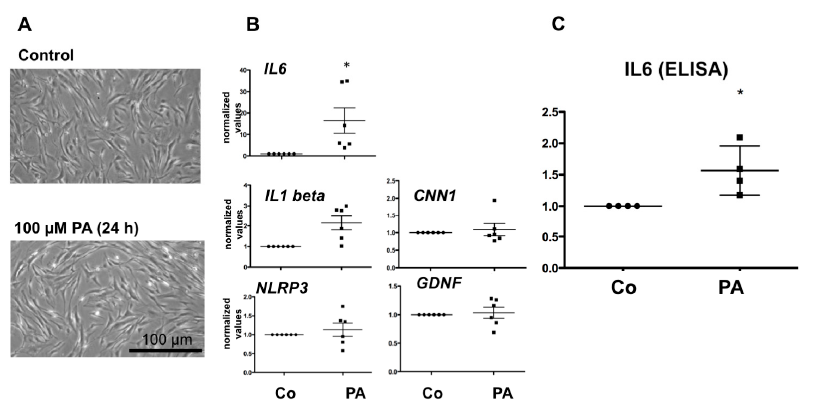
Figure 1. Effect of a 24 h incubation period with 100 µM palmitic acid (PA) on human testicular peritubular cells (HTPCs) compared to the corresponding solvent control (Co) on cellular morphology ( A ), two representative pictures are shown: ( B ) mRNA level of Interleukin 6 ( IL6 ), Interleukin 1 beta ( IL 1beta ), the inflammasome NLRP3, calponinin ( CNN1 ) and glial cell lined derived factor (GDNF ), ( C ) IL6 secretion of HTPCs. n = 6 for mRNA and n = 4 for IL6 protein; individual values of the treatment group are shown, as well as the mean ± SEM; values were normalized to the respective solvent control. Asterisk denotes statistical significance, * p < 0.05.